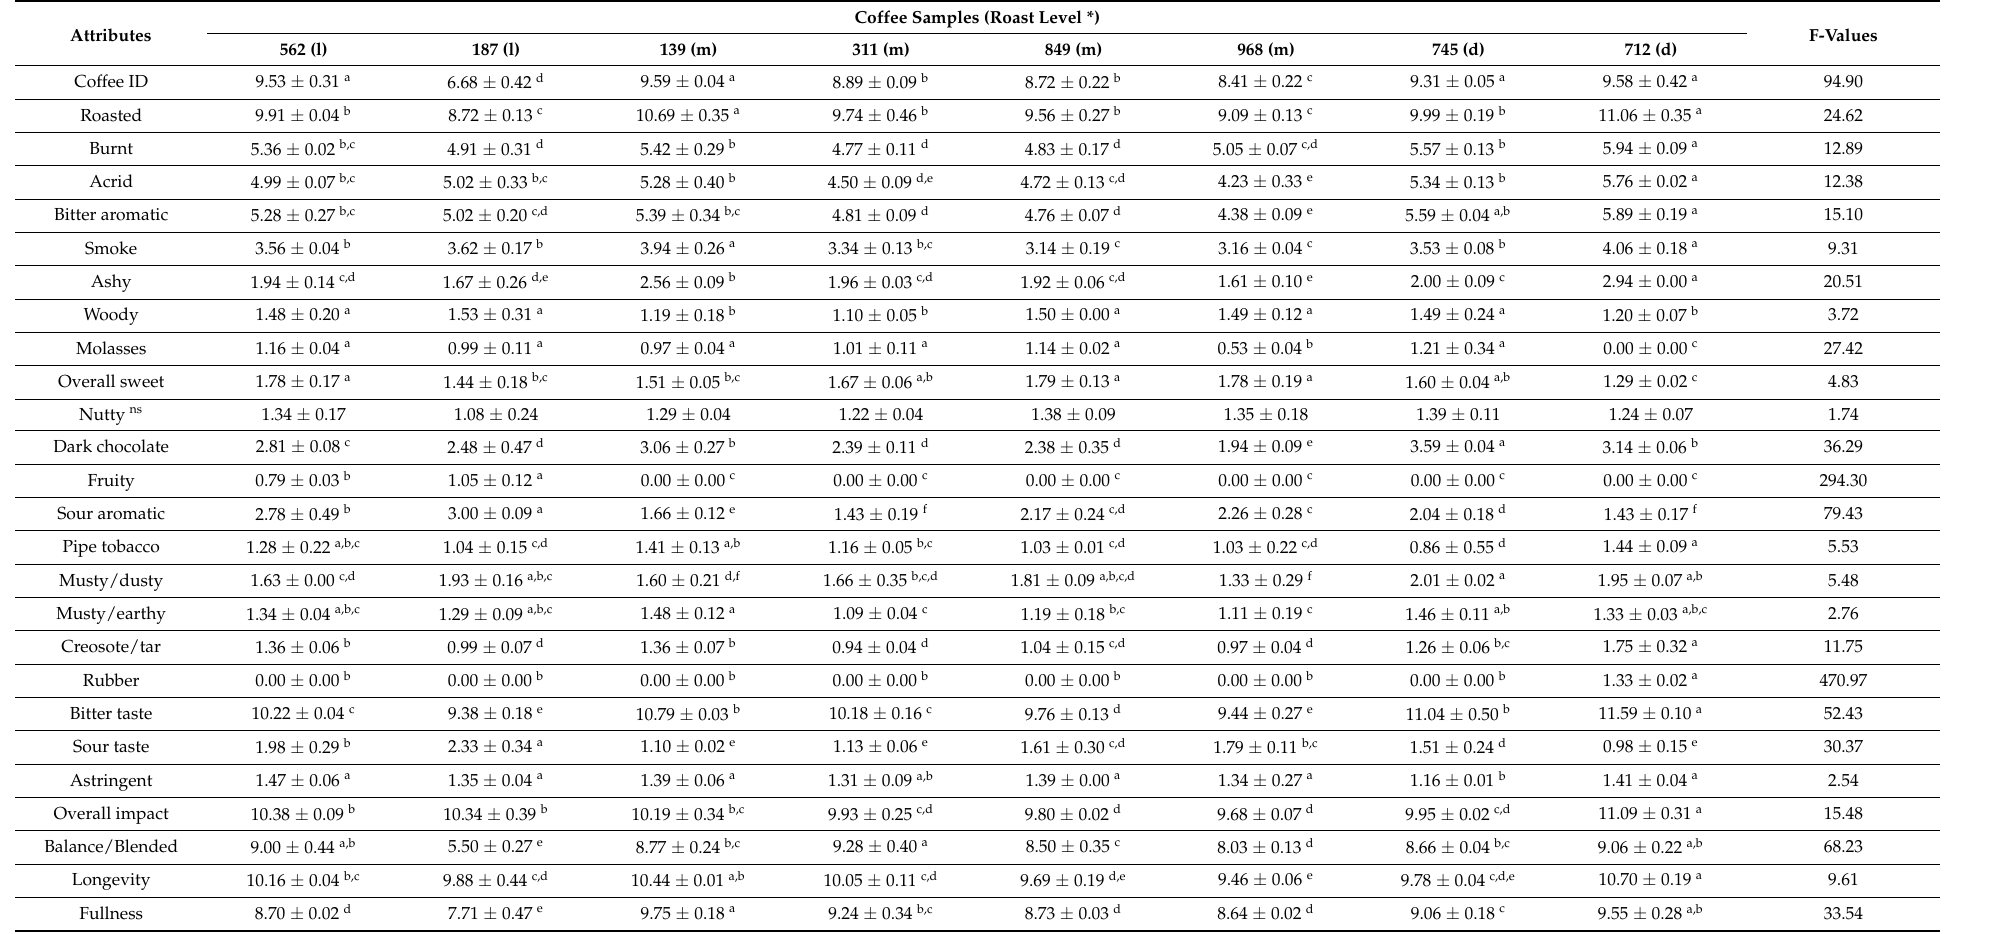
Table 4. Mean intensity scores of sensory attributes for eight black coffee